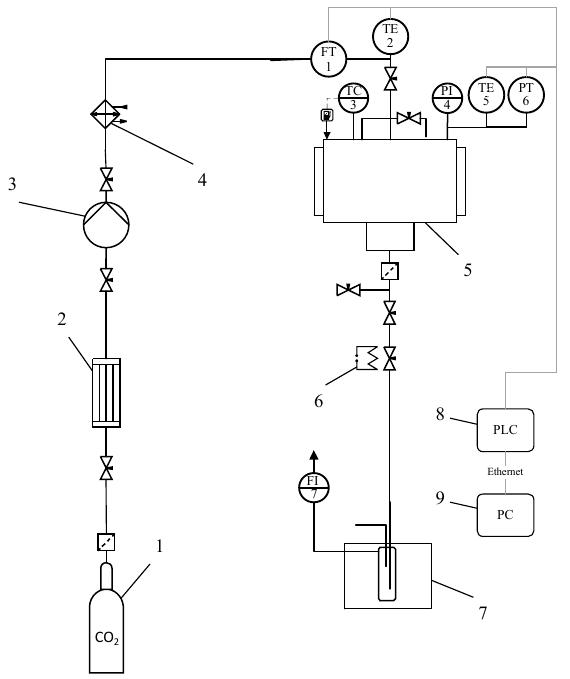
Figure 10. Supercritical drying experimental setup: 1—vessel with liquid CO 2 (60 bar); 2—